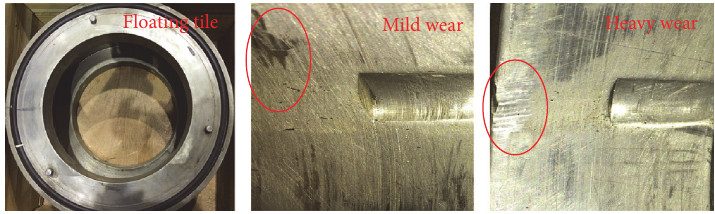
Figure 12: Different conditions of floating